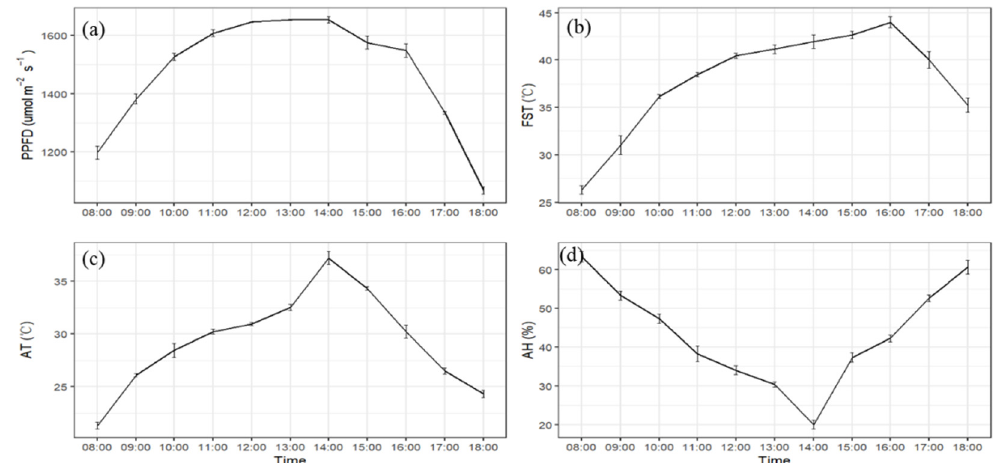
Figure 1. Changes of light intensity, air temperature, humidity, and fruit surface temperature. PPFD: ( a ), photosynthetic photon flux density; FST: ( b ), fruit surface temperature; AT: ( c ), air temperature; AH: ( d ), air humidity. Each index was repeated 5 times.